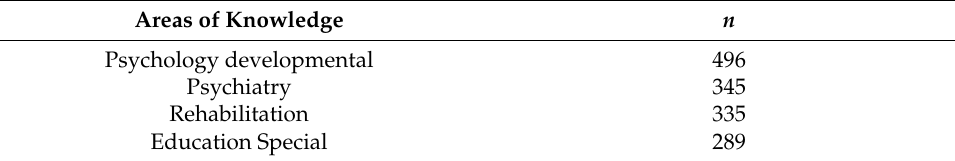
Table 3. Areas of knowledge.